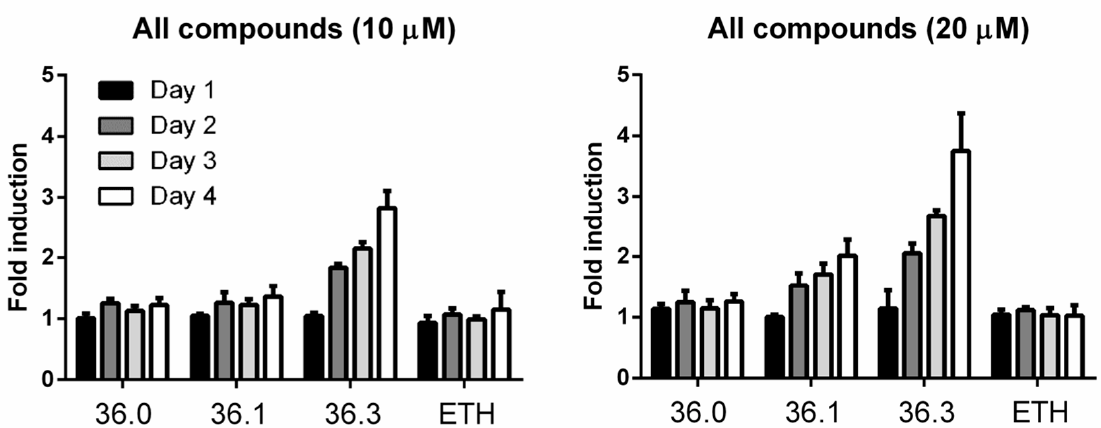
Figure 4. Compounds 36.1 and 36.3 induce the expression of mmar_5294 . M. marinum strain harboring a transcriptional reporter construct for gene mmar_5294 was treated with different amounts of compounds 36.0 , 36.1 , 36.3 , or ETH. Each day, fluorescent intensity (excitation 554 nm/emission 581) was measured. Fold induction was calculated by dividing fluorescent intensity from indicated treated samples to untreated samples.